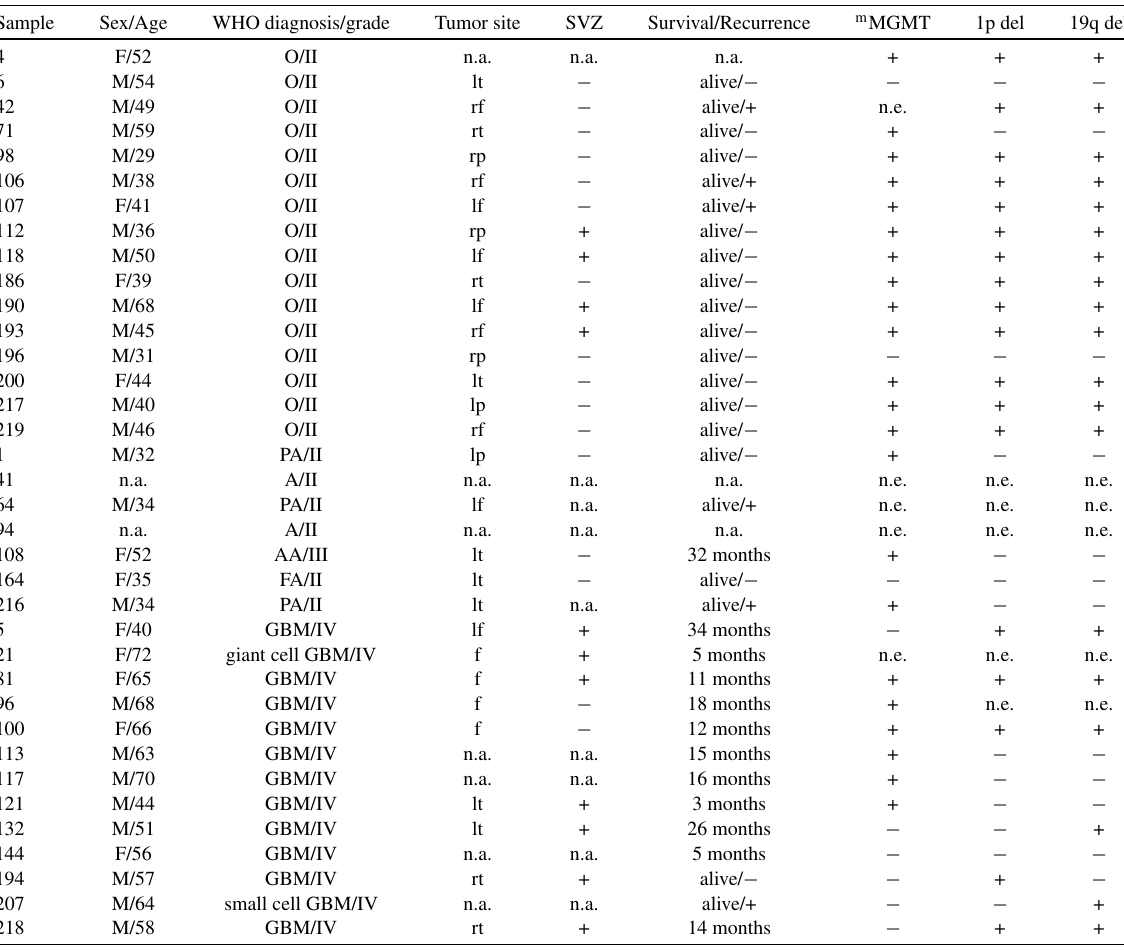
Set of 36 investigated glioma biopsies: molecular and clinical